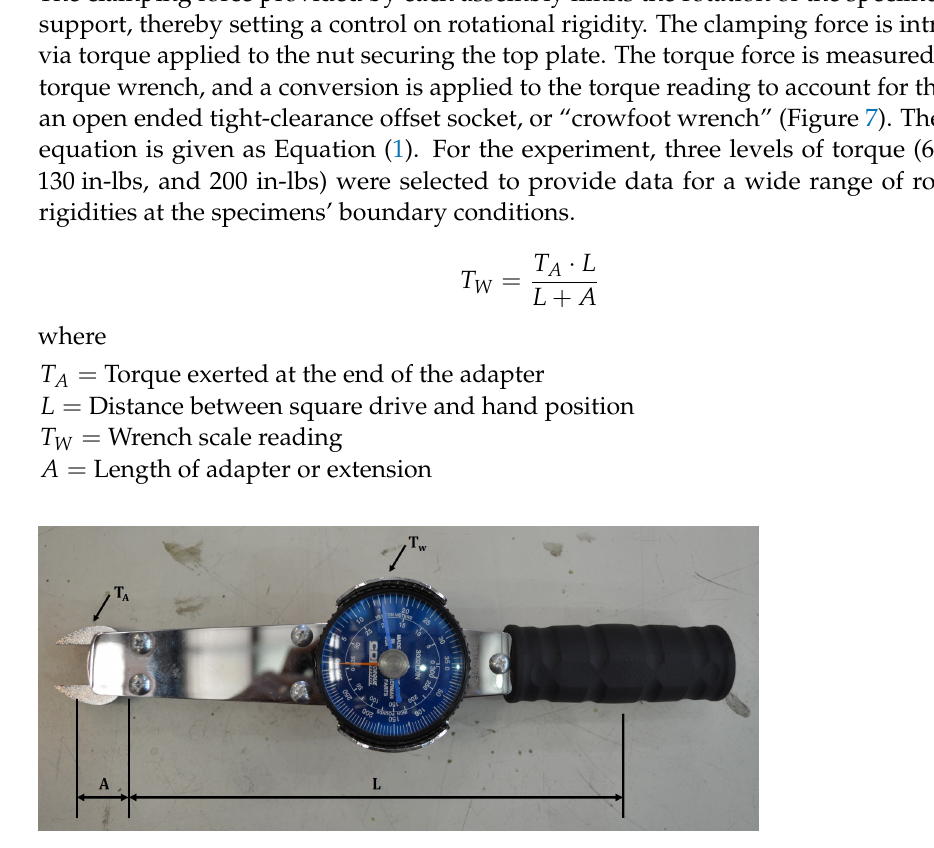
Figure 7. Torque